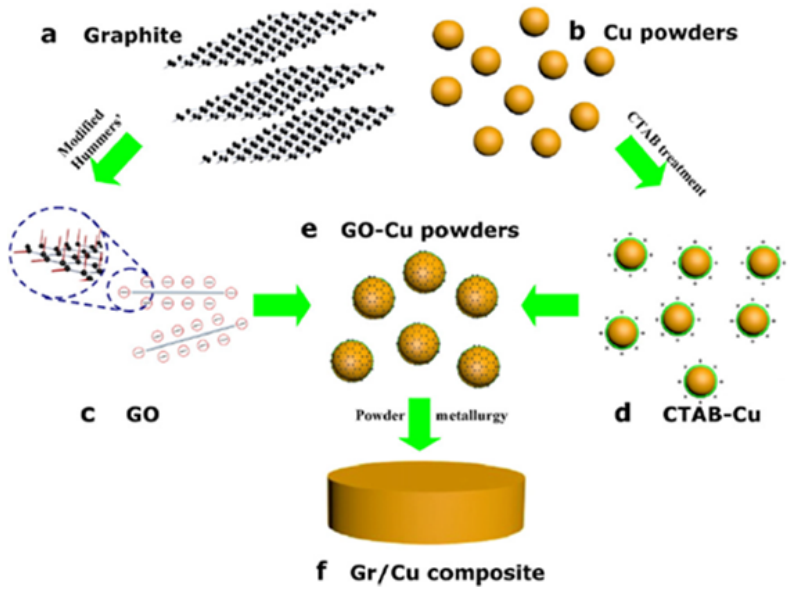
Figure 7: Schematic diagram of the fabrication process of Gr-Cu composite. (a) Graphite, (b) Cu powders, (c) GO with the negative charge, (d) CTAB-modified Cu powders, (e) GO-Cu powders, and (f) Gr/Cu composite. Reproduced from Reference